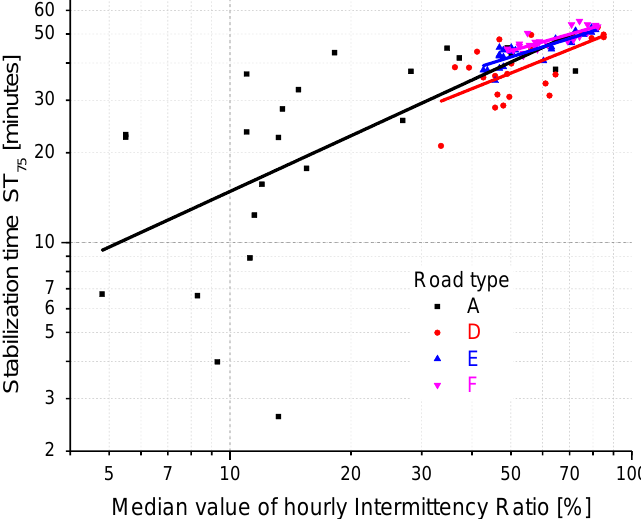
Table 6. Pearson’s correlation coefficients for each road type for IR and L Aeq,1h versus Q h .